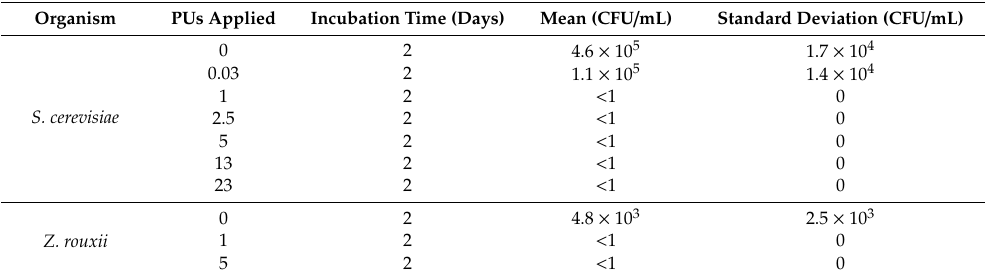
Table 2. E ff ect of various applications of pasteurization units (Pus) on yeast populations for water bath pasteurized bottled ciders.